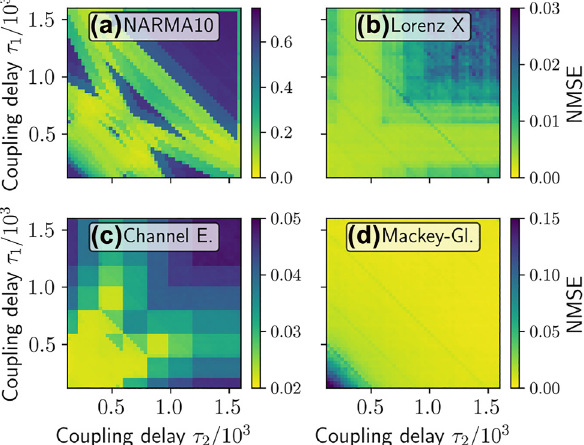
Figure 4: Performance on different tasks: (a) NARMA10, (b) Lorenz x, (c) channel equalization and (d) Mackey–Glass task errors (NMSE) plotted colour coded as a function of 𝜏 system Eq. (9) with two oscillators. Pearson correlation coefficients between the task NMSEs and the IPCs shown in Figure 3 are given in Table 2.